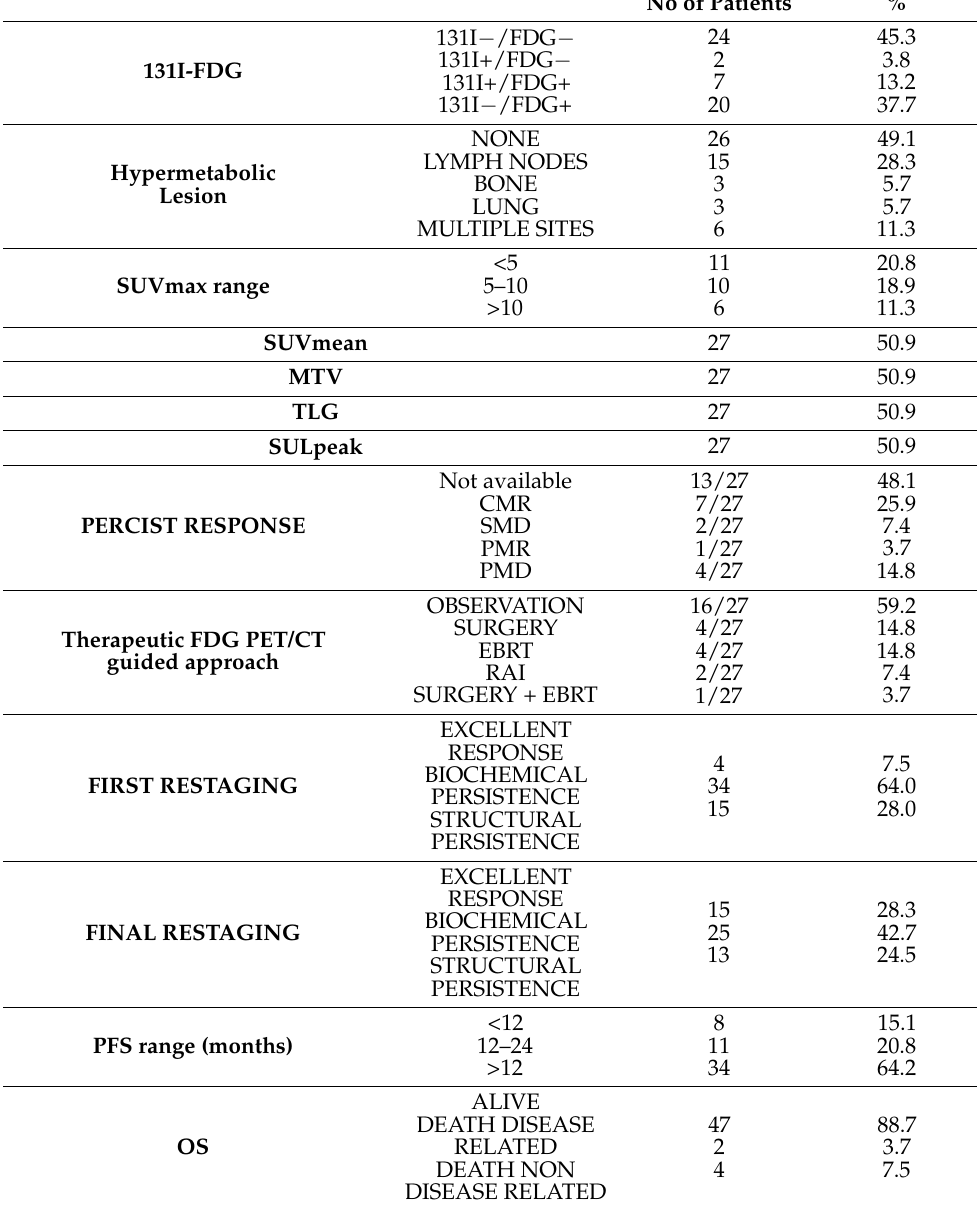
Table 2. Findings on Rx-WBS scan, 18F-FDG/PET scan, restaging, PERCIST response, and final